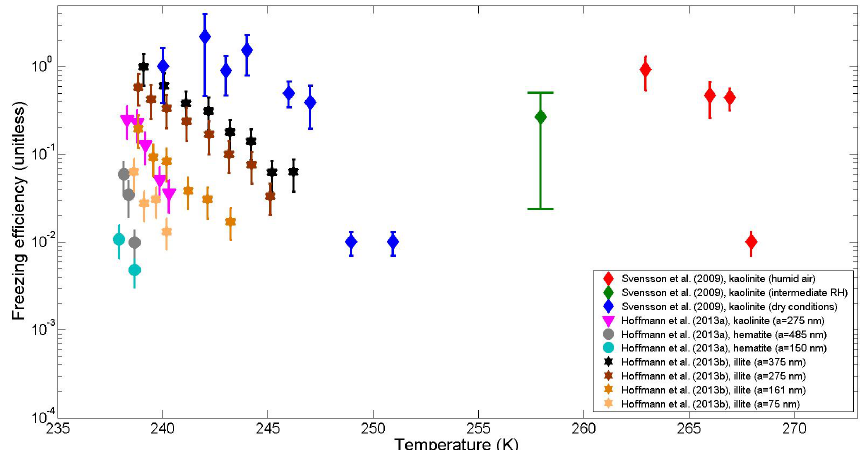
Fig. 9. Experimental freezing efficiencies (FE) of several materials obtained with an EDB. The red, green and blue diamonds represent the kaolinite experiments (polydisperse aerosol particles) from Svensson et al. (2009) at high, intermediate and low relative humidity with respect to water. The purple triangles and the colored circles represent the kaolinite and hematite results from Hoffmann et al. (2013b), respectively. The black, brown, dark yellow and orange stars represent the illite FE for 375, 275, 161 and 75nm, respectively (Hoffmann et al., 2013a).